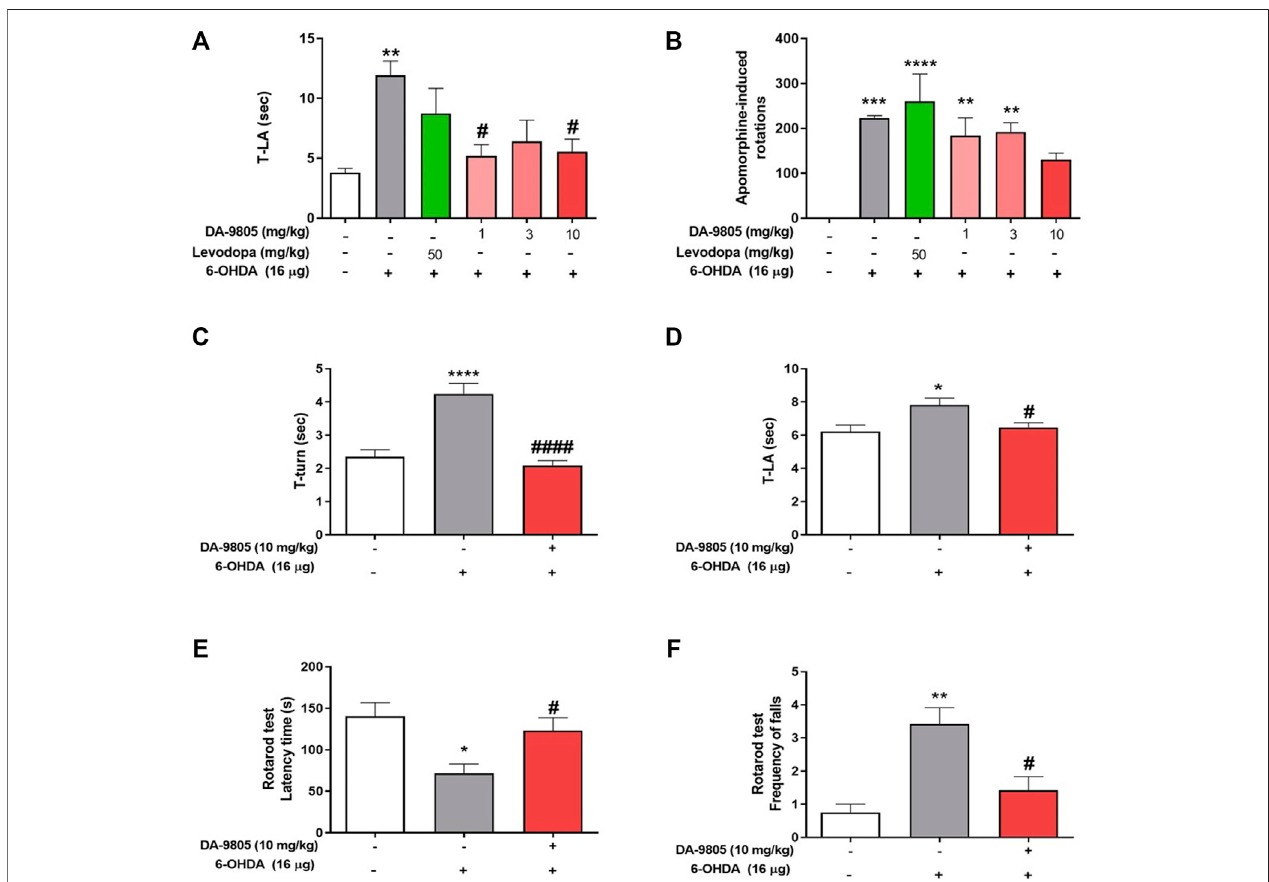
FIGURE 1 | Optimal condition of DA-9805 for alleviating motor in 6-hydroxydopamine (6-OHDA)-lesioned mice. The time to arrive to the ground (T-LA) were evaluatedinpoletest (A) andnetrotationsinducedbyapomorphinefor25 min (B) .Thetimetoturn(T-turn) (C) andT-LA (D) wereevaluatedinpoletestandlatencytime and the frequency of falls from the rod during 180s were estimated in rotarod test (E,F) . Value are given as the mean ± S.E.M (A – D) Data were analyzed by One-way ANOVA followed by post hoc Bonferroni ’ s multiple comparisons test. (E,F) Data were analyzed by Kruskal-Wallis test followed by post hoc Dunn ’ s multiple comparisons test with non-normal distribution. * p < 0.05, ** p < 0.01, *** p < 0.001 and **** p < 0.0001; compared to the sham group. # p < 0.05 and #### p < 0.0001; compared to the 6-OHDA group. N = 6 per group.